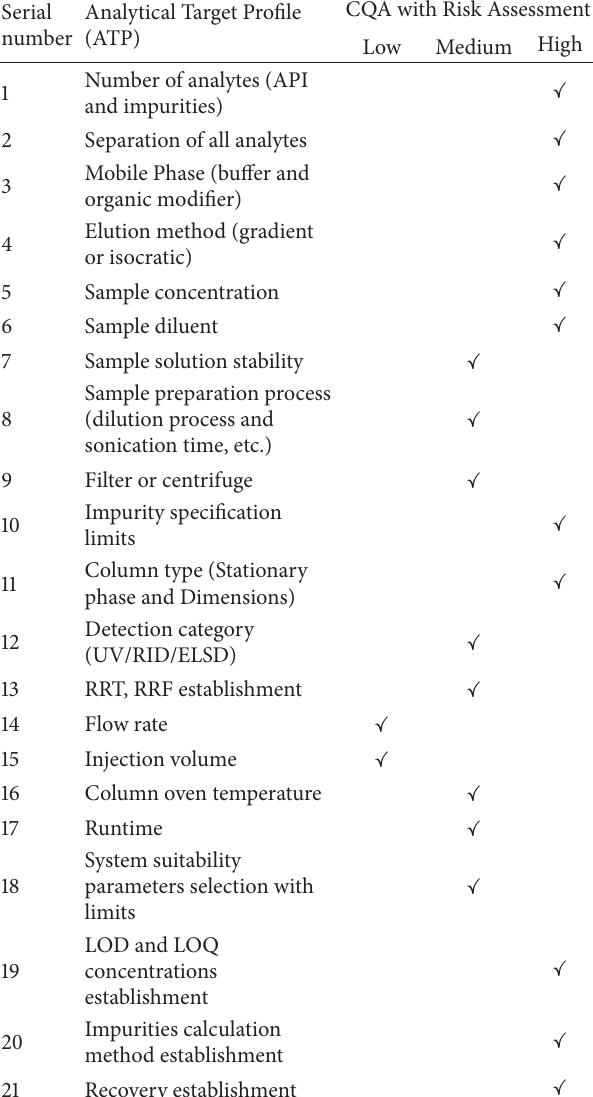
Table 3: Common ATPs for impurity profile by HPLC